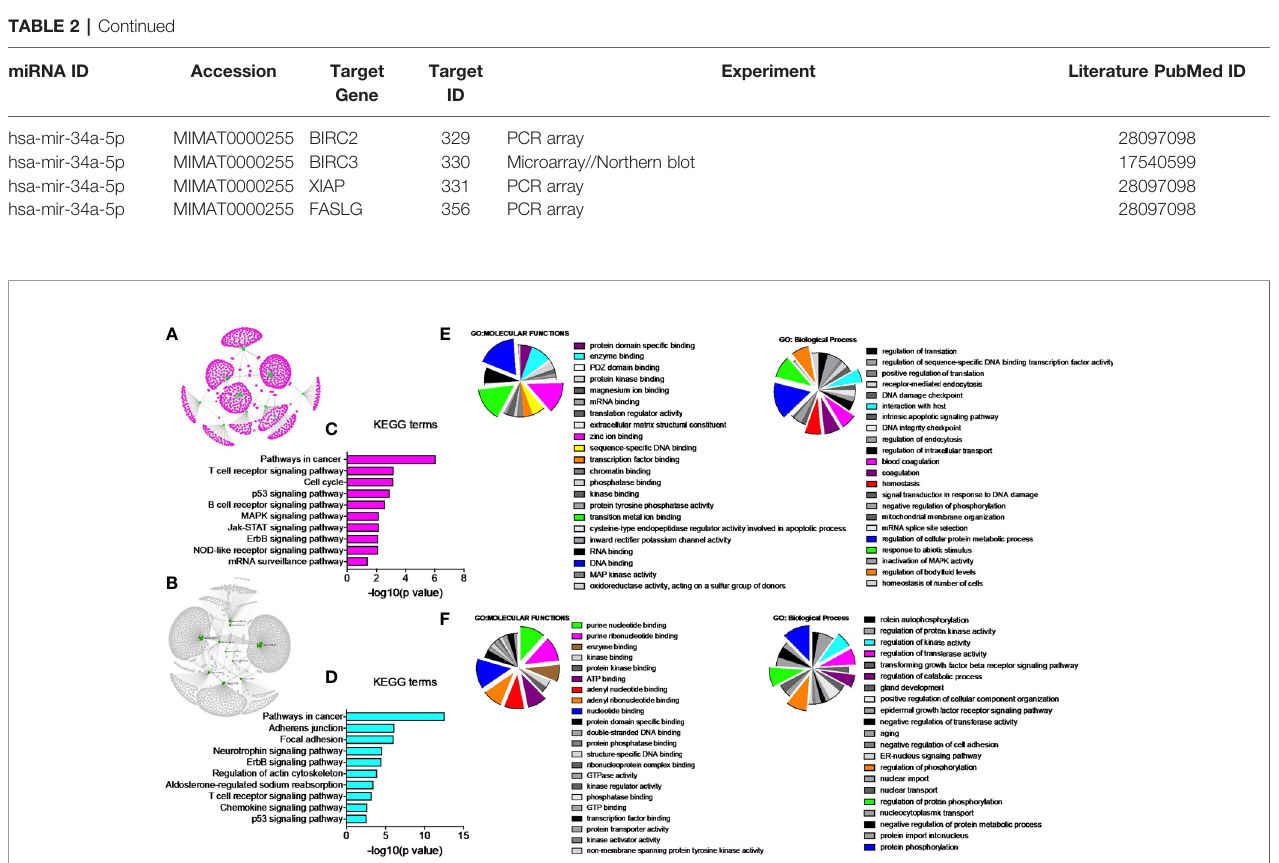
FIGURE 3 | PGRMC1 silencing alters pathways that are have miRNA target genes involved. Silencing PGRMC1 upregulates different miRNAs (from AG-205 treatment) that target similar miRNA target genes which are also upregulated in metastatic breast cancer samples. (A) Target genes highlighted in pink of the top ten most upregulated miRNAs highlighter in green. (B) The top ten most downregulated miRNAs highlighted in green and their direct targets highlighted in grey. (C) and (D) The top 10 most signi fi cantly enriched pathways (non-disease related) were identi fi ed by KEGG analysis, adjusted p < 0.05. (E, F) miRNA target genes show involvement in GO: terms Molecular functions and Biological